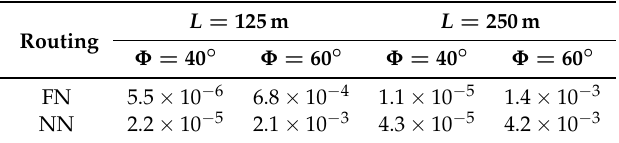
Figure 5. P out : EE versus β with m, λ = 0.015, Φ = { 40 ◦ ,60 ◦ } , and R = { 50 m, 33.3 m } . Table 1. Blockage-free end-to-end (EE) outage probability P out : EE .